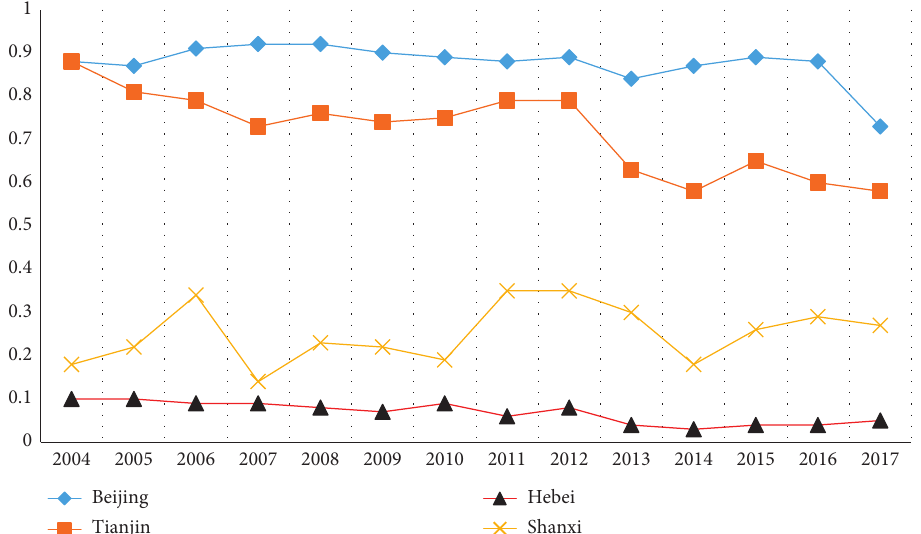
Figure 2: GFI in north China from